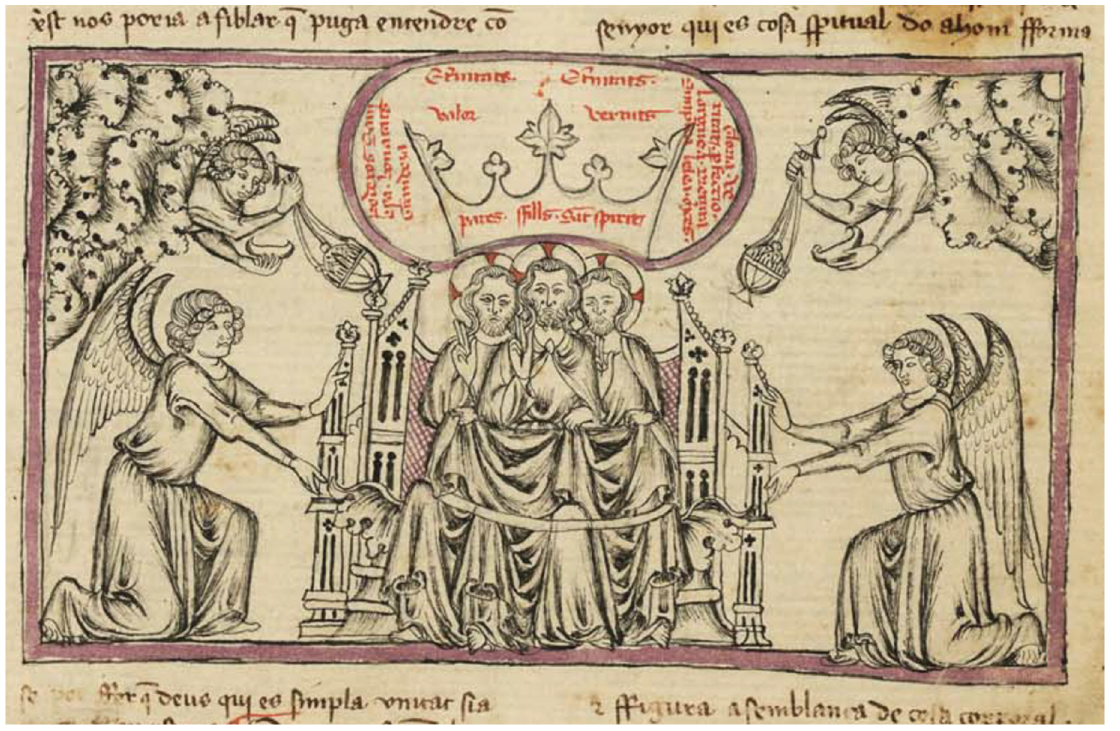
Figure 7. Trinity, Breviari d’Amor, Matfré Ermengaud, fourteenth century (Res/203, fol. 9r). Biblioteca Nacional de España (Madrid). (Source: Biblioteca Digital Hispánica, BNE: http://bdh.bne.es/bnesearch/detalle/bdh0000135155) (accessed on 27 May 2022), Imagen procedente de los fondos de la Biblioteca Nacional de España.